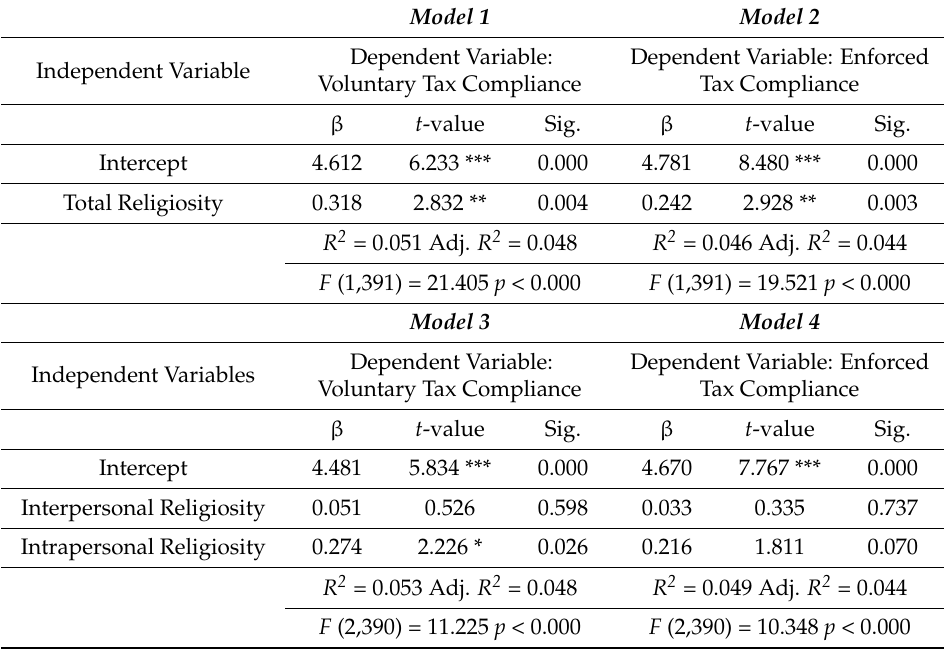
Table 5. Regression